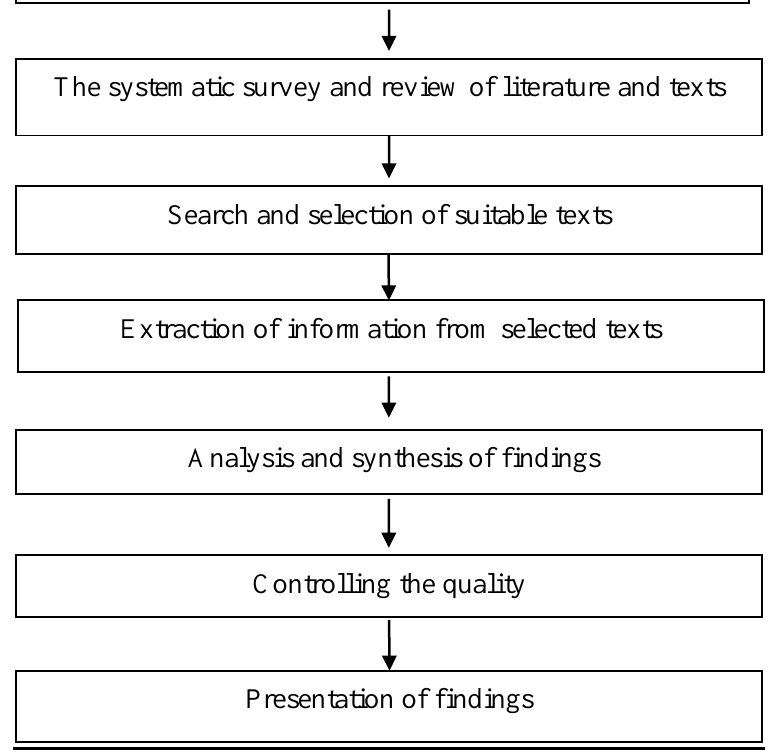
Fig.1. phases of implementing meta-synthesis